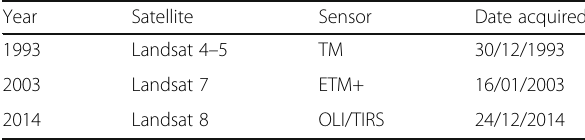
Table 1 Characteristics of remote sensing